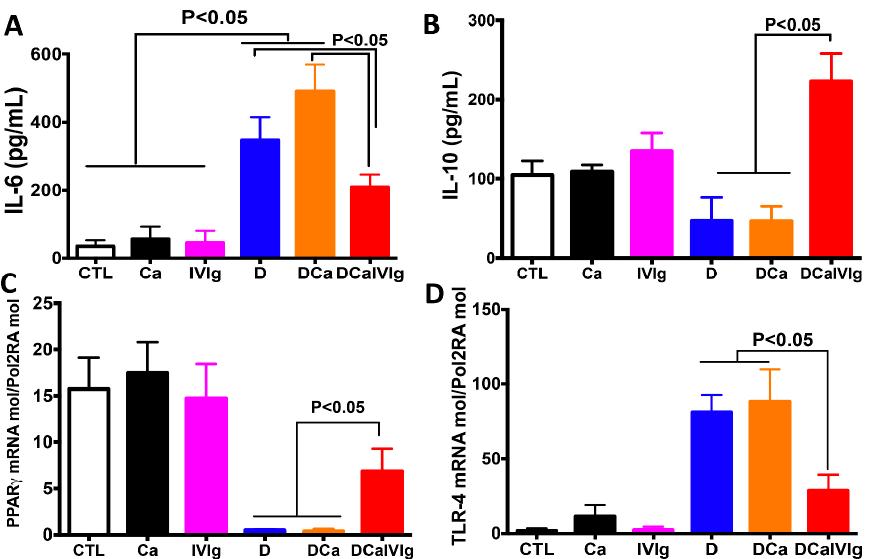
Figure 5. Cytokine and receptor expression after intravenous immunoglobulin (IVIg) treatment of mice with C. albicans and dextran sulfate sodium (DSS)-induced colitis. ( A and B ) Protein levels of interleukin (IL)-6 and IL-10 in mouse colons. ( C and D ) Relative expression of peroxisome proliferator-activated receptor gamma (PPAR γ ) and toll-like receptor 4 (TLR-4) mRNA in mouse colons. Data are the mean ± SD of 14 mice per group.